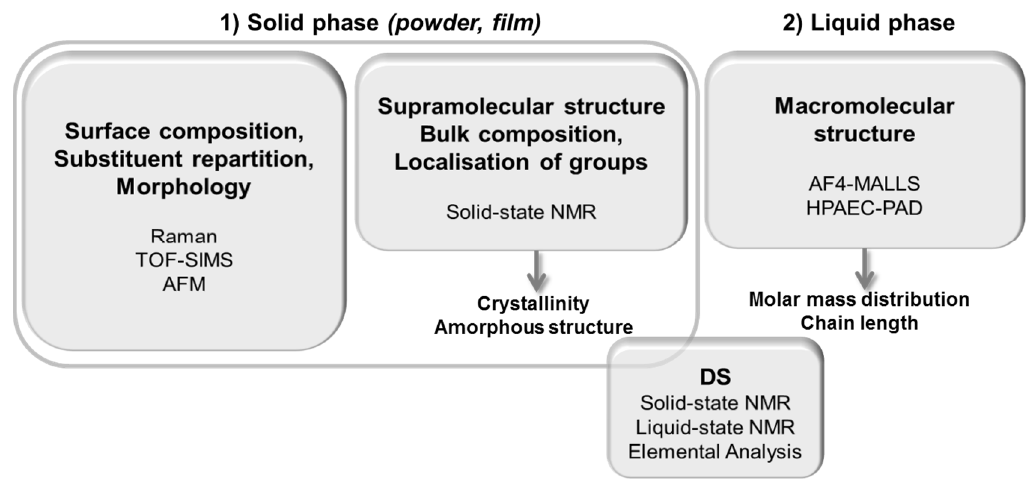
Figure 10. Designed strategy for multi-scale and multi-state characterization of high molar mass chemically-modified starches with 0.4 < DS ≤ 3.